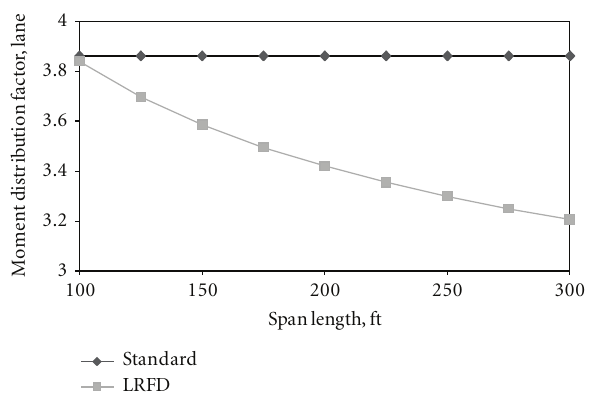
Figure 4: Moment distribution factors for a box girder (seven cells spaced at 9ft) for standard and LRFD specifications.